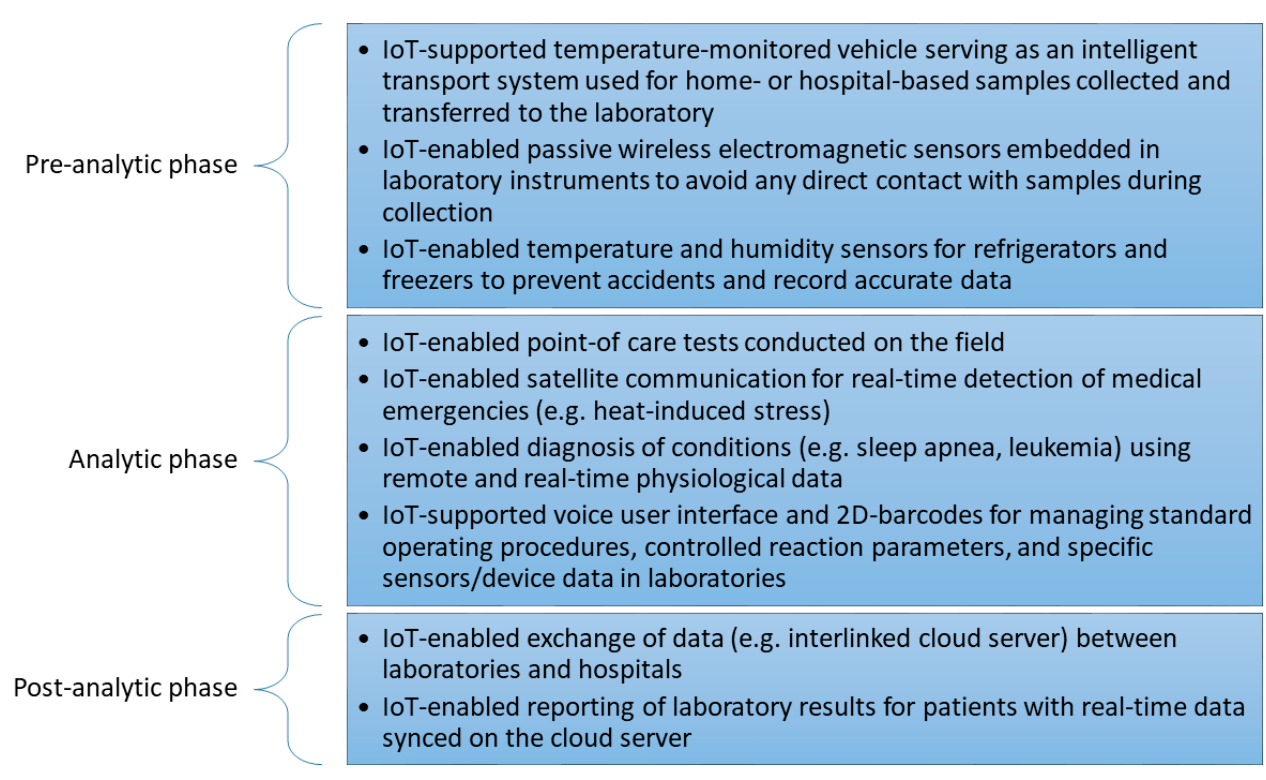
Figure 6. Specific functions of identified IoT focal points in all investigations’ clinical laboratory processes.